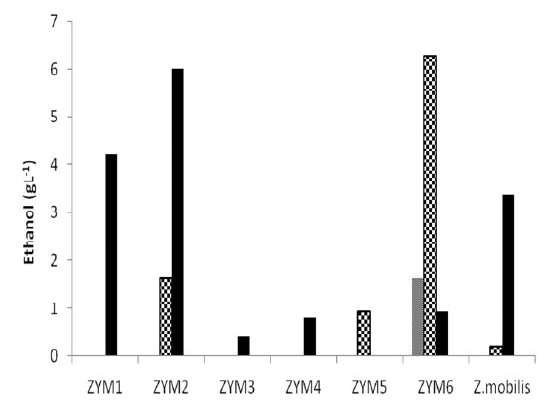
Fig 4. Effect of temperature on producing ethanol by isolates. ( ) 25 °C, ( ) 30 °C, ( ) 35 °C and ( ) 40